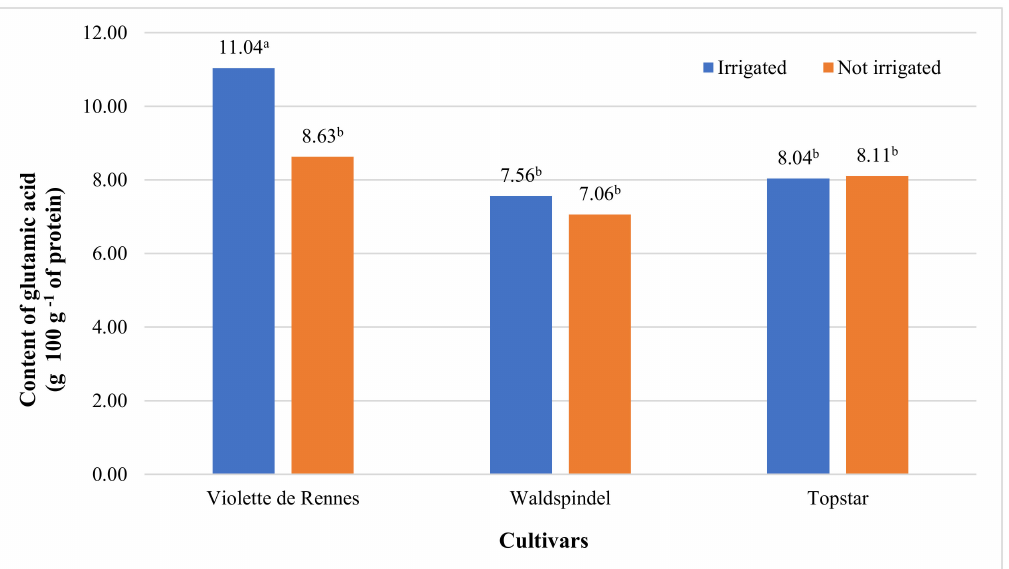
Figure 7. The e ff ect of irrigation on the glutamic acid content of tubers in the analyzed Jerusalem artichoke cultivars. Means with the same letters do not di ff er significantly at p ≤ 0.05 in Tukey’s test. The absence of letters denotes non-significant main e ff ects.